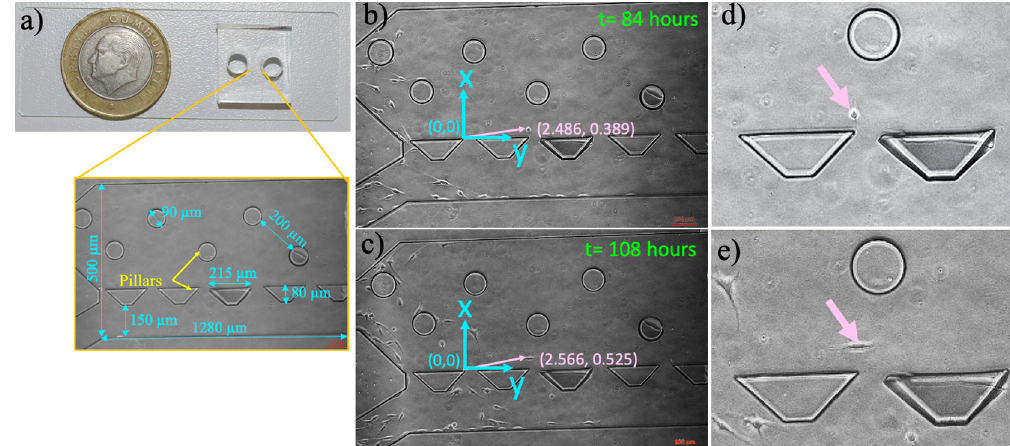
Figure 1. Microfluidic cell culture platform and measurement of single-cell migration in the microfluidic device. ( a ) The polydimethylsiloxane (PDMS) microfluidic chamber on a glass slide, ( b ) the micrographs of microfluidic chamber with pointed pillars and dimensions. ( c ) The blue line indicates the position of the coordinate system (0, 0) with x - and y -axis. The pink arrow points to the position of a cell according to origin, ( b ) x: 2.486, y: 0389 at 84 h, ( c ) x: 2.566, y: 0.525 at 108 h, ( d ) and ( e ) demonstrate the zoomed images of this cells in ( b ) and ( c ), respectively. The scale bar shows 100 μ m.